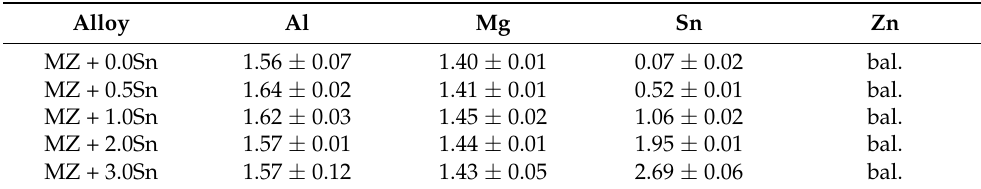
Table 1. Chemical composition of the studied alloys (wt.%). Alloy Al